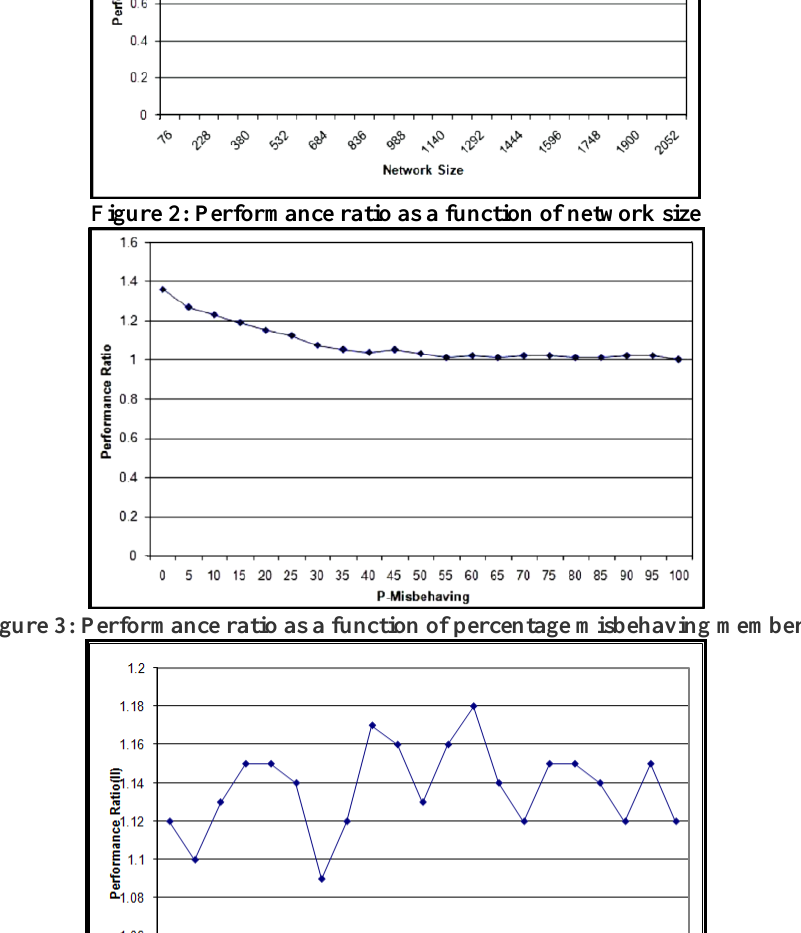
Figure 1: Performance ratio as a function of variety